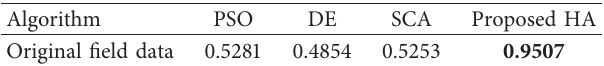
Table 8: The correlation coefficient between the obtained scattered field data and the original field data. Algorithm